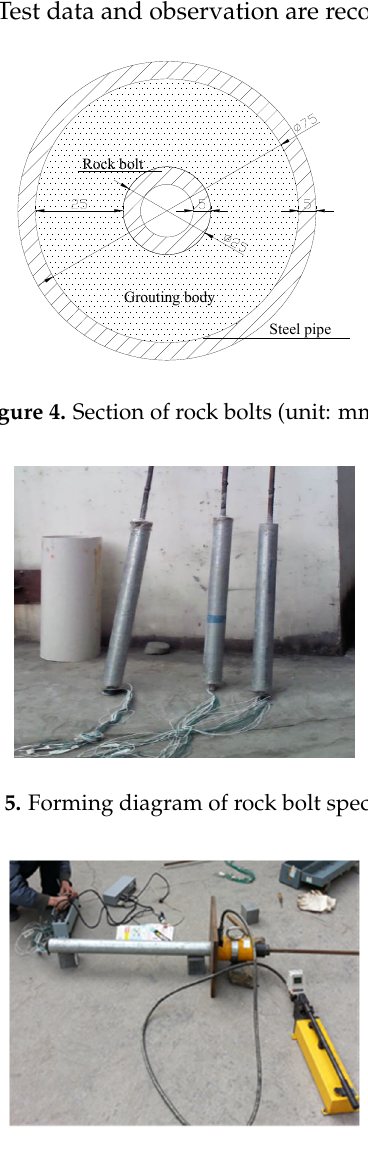
Figure 6. Tensile test of rock bolts.